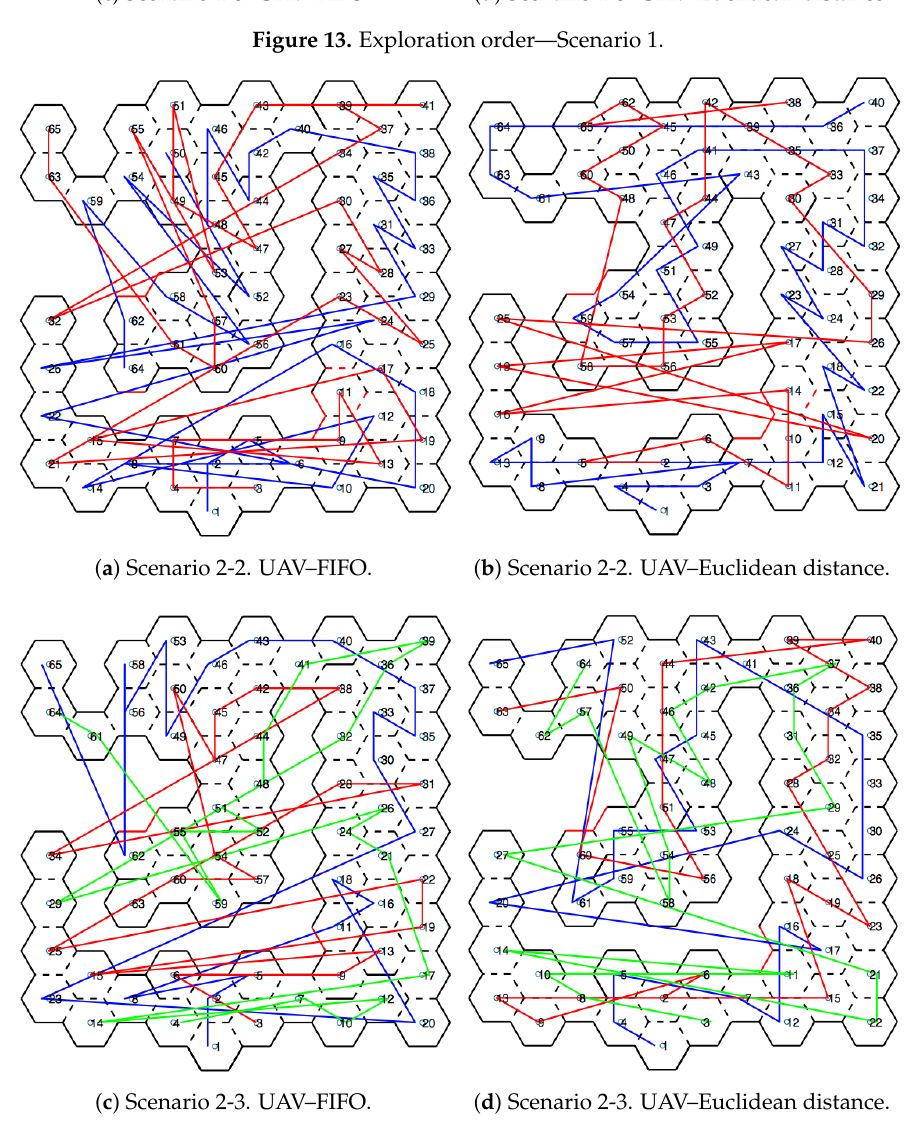
Figure 14. Exploration order—Scenario